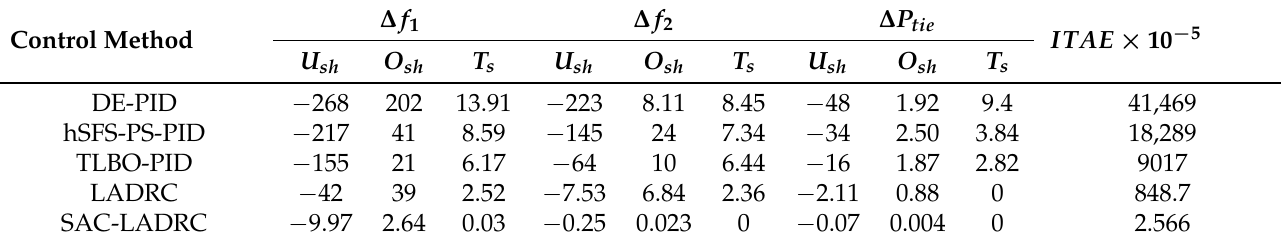
Figure 9. Controller parameters of gas turbine plant. Table 4. Comparison of performance indicators of different control